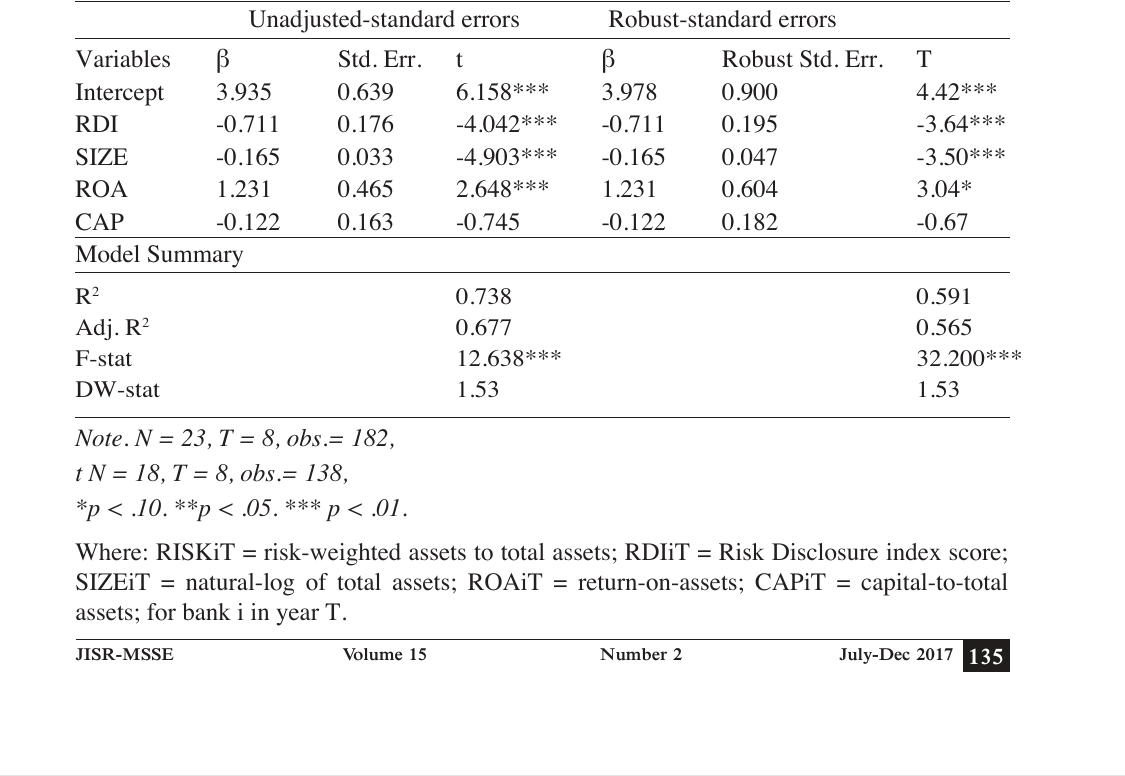
Table 3: Regression Estimates using